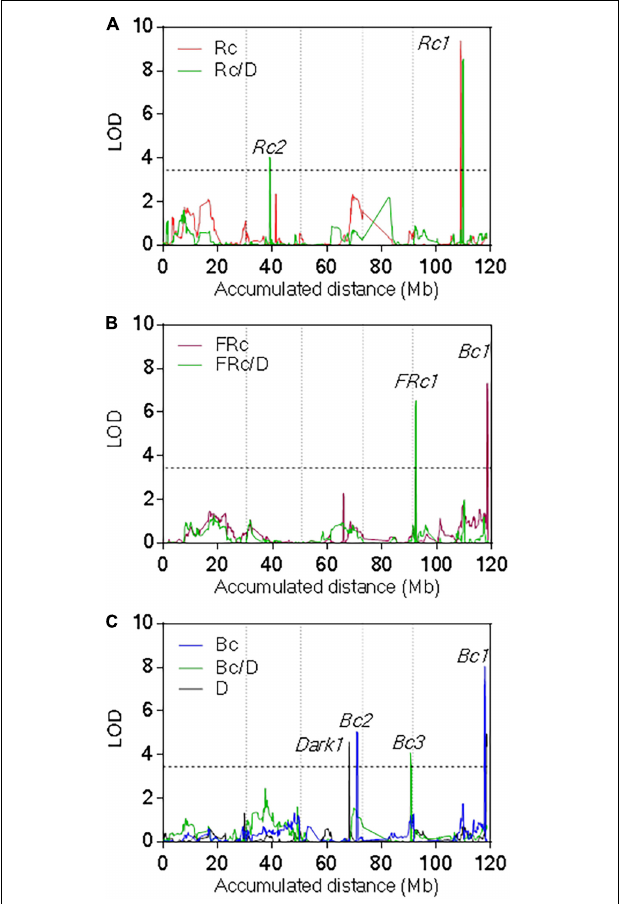
FIGURE 3 | Quantitative trait loci mapping for seedling de-etiolation. QTL mapping for (A) Rc and Rc/dark, (B) FRc and FRc/dark, and (C) Bc, Bc/dark, and dark. LOD score is shown for the accumulated distance of the five chromosomes separated by vertical dashed lines. The horizontal dashed line indicates the significance threshold